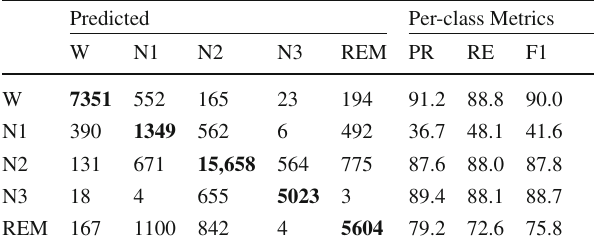
Table 6 Confusion matrix using the proposed method Predicted Per-class